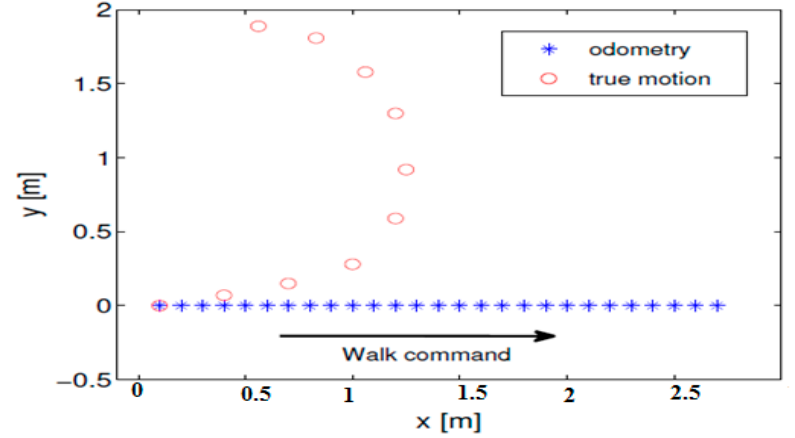
Figure 13. Actual robot trace and reported odometry for a straight walk command